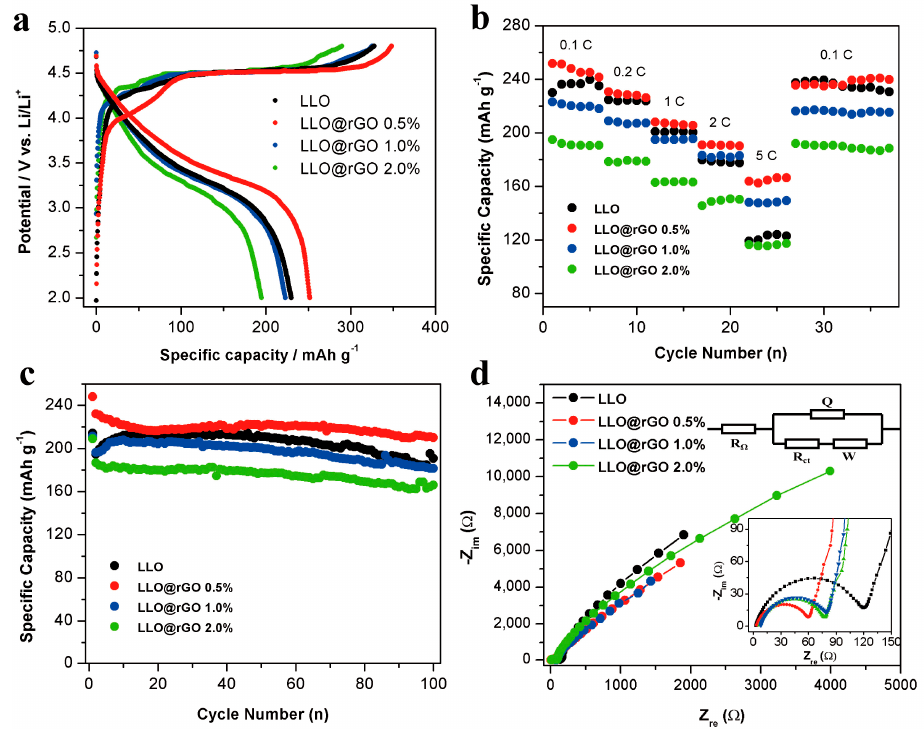
Figure 7. Electrochemical performances of the as-prepared LLO@rGO electrodes with different amounts of rGO: ( a ) The initial charge and discharge profiles at 0.1C, ( b ) rate capability, ( c ) cycling stability, and ( d ) EIS plots, and the corresponding fitting using an equivalent circuit.